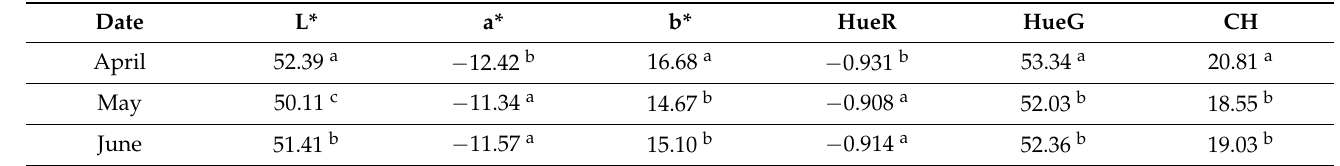
Table 2. L*, a*, b*, hue, and chroma in tuberose leaves established in April, May, and